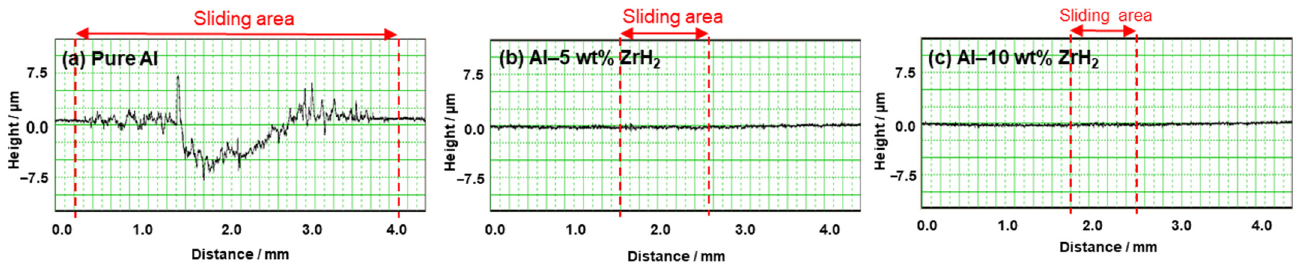
Figure 10. Surface roughness profiles of the wear track of SUS304 disk under an applied load of 4.9 N using ( a ) pure Al, ( b ) Al–5 wt% ZrH 2 , and ( c ) Al–10 wt% ZrH 2 pin specimens.